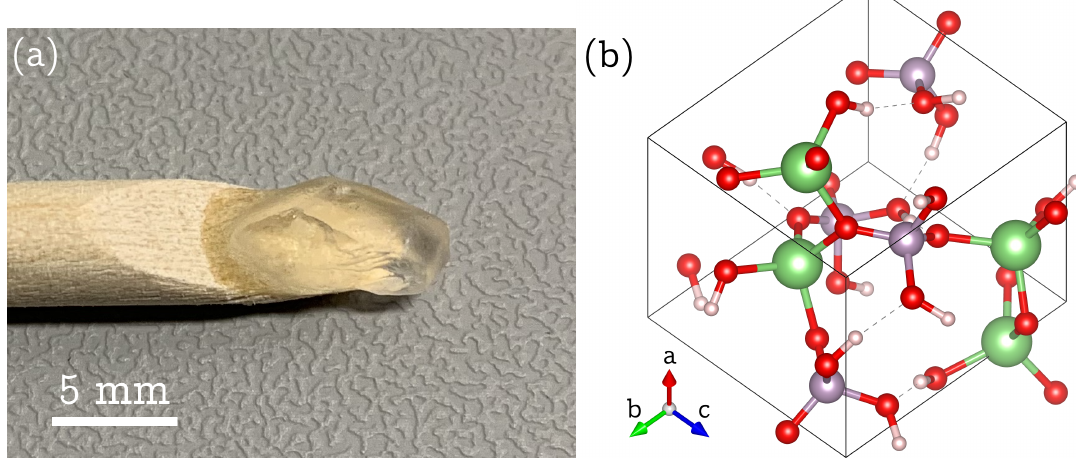
Figure 1. (a) Single crystal of aluminum nitride, AlN, from Leibniz Institute for Crystal Growth (IKZ, Figure 1. ( a ) LiH 2 PO 4 (LDP) single crystal, synthesised according to literature [7] and fixed on a wooden rotation axis using dual-component adhesive. ( b ) Orthorhombic structure of LDP (space group Berlin), with the crystallographic c axis and ab plane indicated by arrows.[10] (b) Wurtzite structure Pna 2 1 , No. 33), according to Reference [6], with the chosen view down the crystallographic [111] of AlN, according to Reference [9], viewed down the crystallographic (11-20) direction. The aluminum direction. All atoms in the unit cell are located at Wyckoff position 4 a , with the lithium atoms (green) atoms (grey) and the nitrogen atoms (yellow), both located at Wyckoff position 2 b , are tetrahedrally and the phosphorus atoms (purple) both tetrahedrally coordinated by oxygen (red). The hydrogen coordinated by each other with one Al-N bond directed parallel to the crystallographic c axis. (c) Individual, atoms (ivory) stabilize the crystal structure by forming hydrogen bonds (dotted lines) between the PO 4 tetrahedrally coordinated, aluminum and nitrogen atom in the crystal structure of AlN, in which the three and LiO 4 tetrahedra. (Drawing generated with the V ESTA program equal, shorter, bonds Al/N—I/II/III [1.8891(8) Å] and the longer bond Al/N—IV [1.9029(16) Å] along the three-fold rotation axis are highlighted. a Drawing generated with the Vesta program [11].